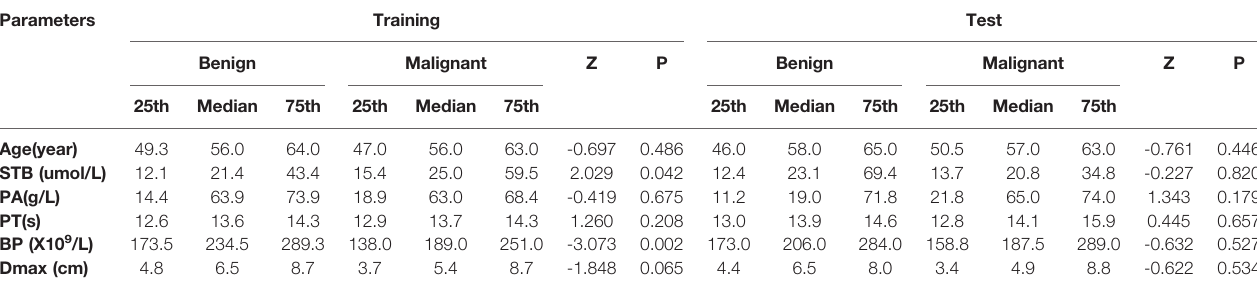
TABLE 2 | Characteristics of patients in the training and test cohorts (2). Parameters